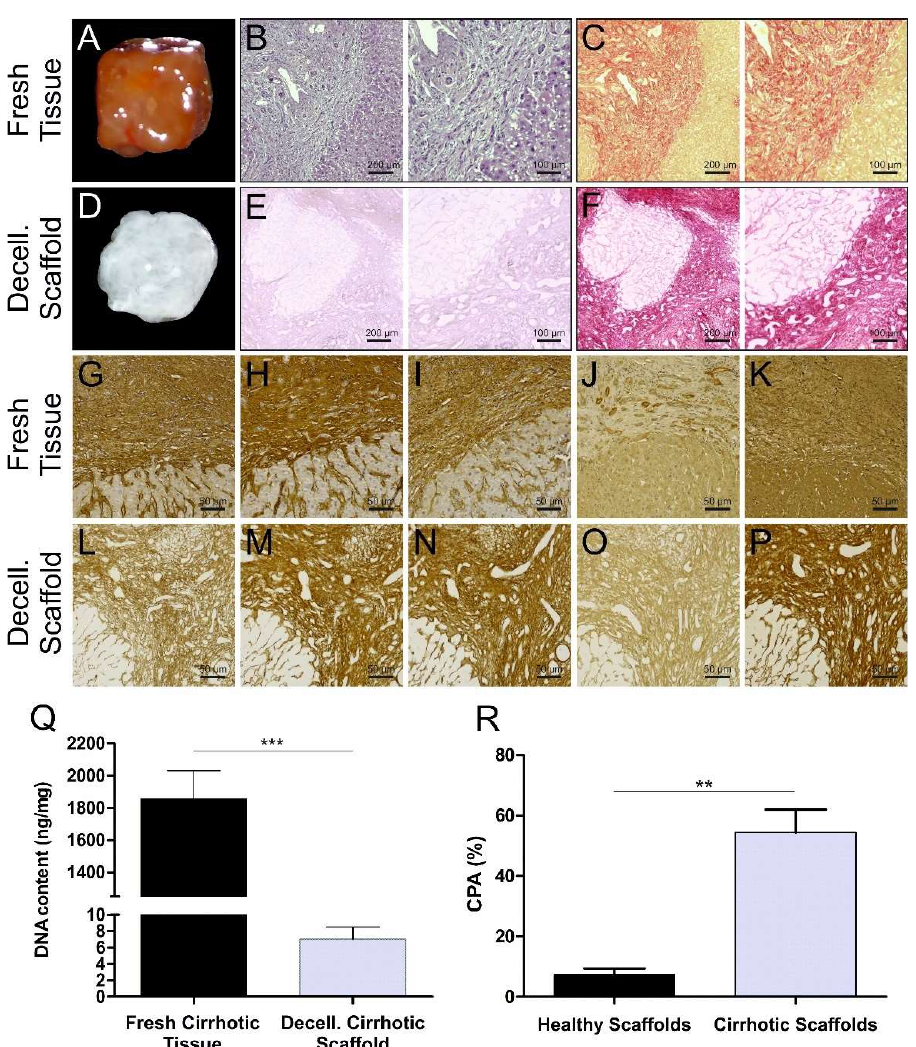
Figure 1. Macroscopic characterization of decellularization of human liver 3D scaffolds. ( A ) Macroscopic appearance of native cirrhotic liver 3D scaffold before and ( D ) after decellularization. ( B , C ) Histological comparison of cirrhotic native tissue and ( E , F ) decellularized 3D scaffold after staining with Haematoxylin and Eosin (H&E) showing acellularity (E) and Sirius Red (SR) collagen preservation (F), respectively (scale bars, 100–200 µm). ( G – P ) Distribution of several ECM proteins; collagen I, collagen III, collagen IV, fibronectin, and laminin, respectively, evaluated by immunohistochemistry showing consistency between the native tissue (top panel, G– K ) and decellularized 3D cirrhotic scaffolds (bottom panel, L –P) (scale bars, 50 µm). ( Q ) DNA quantification showing significant elimination of DNA in the native fresh tissue versus 3D cirrhotic scaffolds ( n = 4 for each condition, *** p < 0.0005 native tissue versus 3D scaffold). ( R ) Collagen proportional area (CPA) showed a significant difference between healthy and cirrhotic 3D scaffolds (** p < 0.021: Median normal 7.5%, LQ-UQ 3.8%–11.1% versus cirrhotic median 53.7%, LQ-UQ 40.6%–69%).